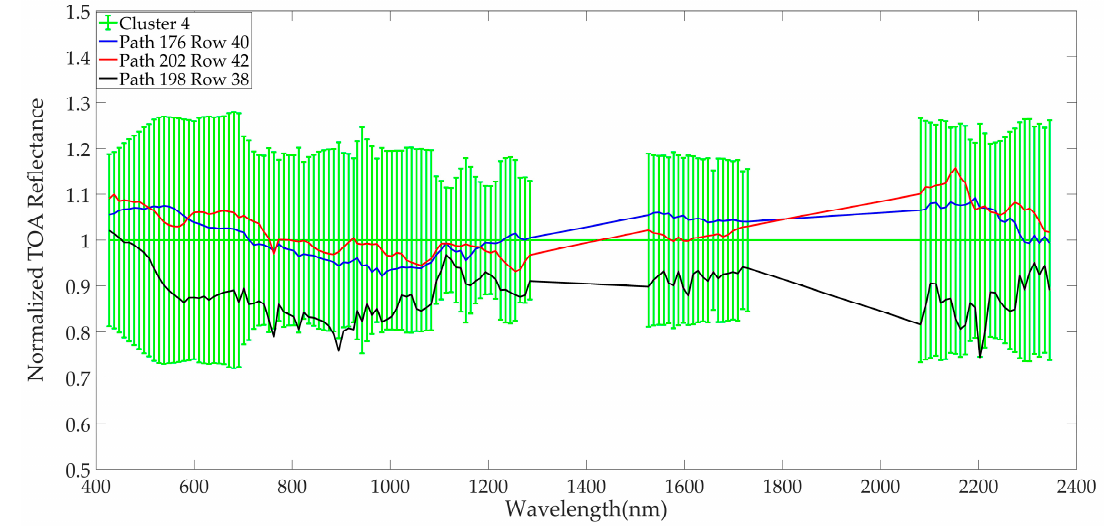
Figure 18. Validation of hyperspectral spectrum of Cluster 4.